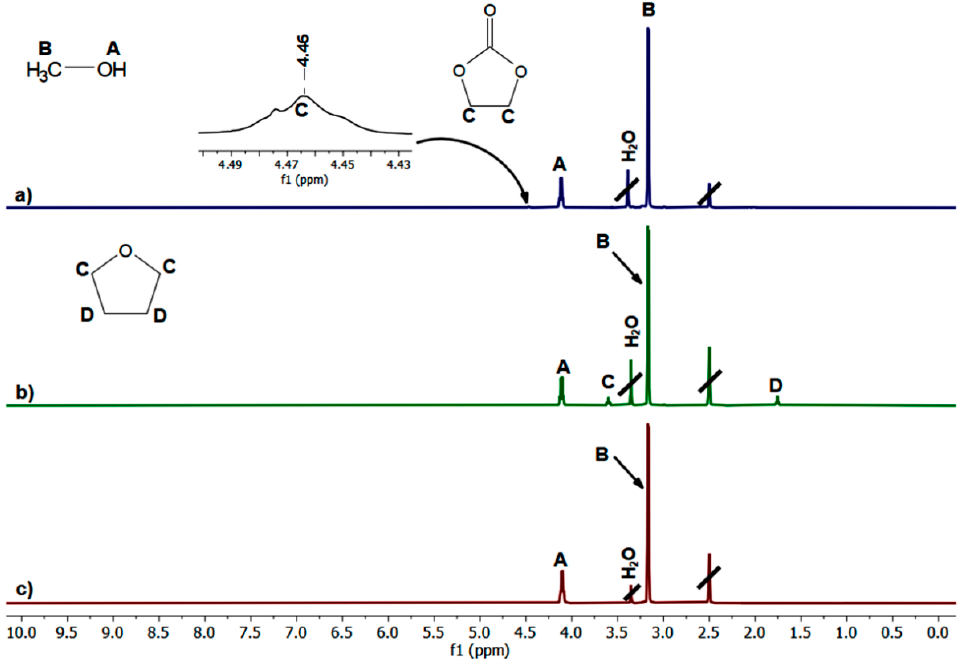
Figure 3. The composition comparison of BHAC products 1_2 ( a ), 1_4 ( b ), and 1_10 ( c )’s